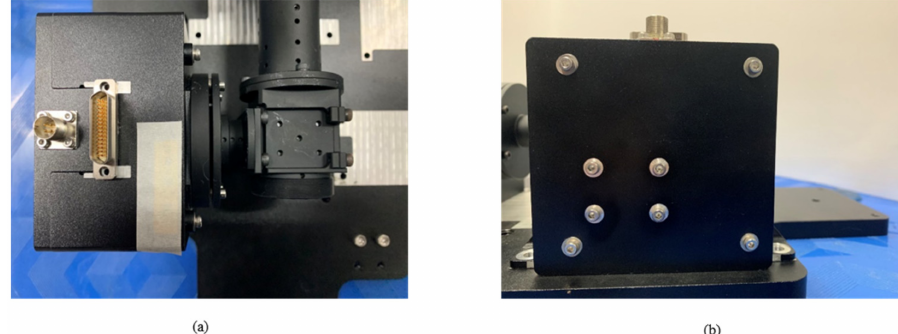
Figure 9. Wide-field optical system. ( a ) Top view; ( b ) left view.